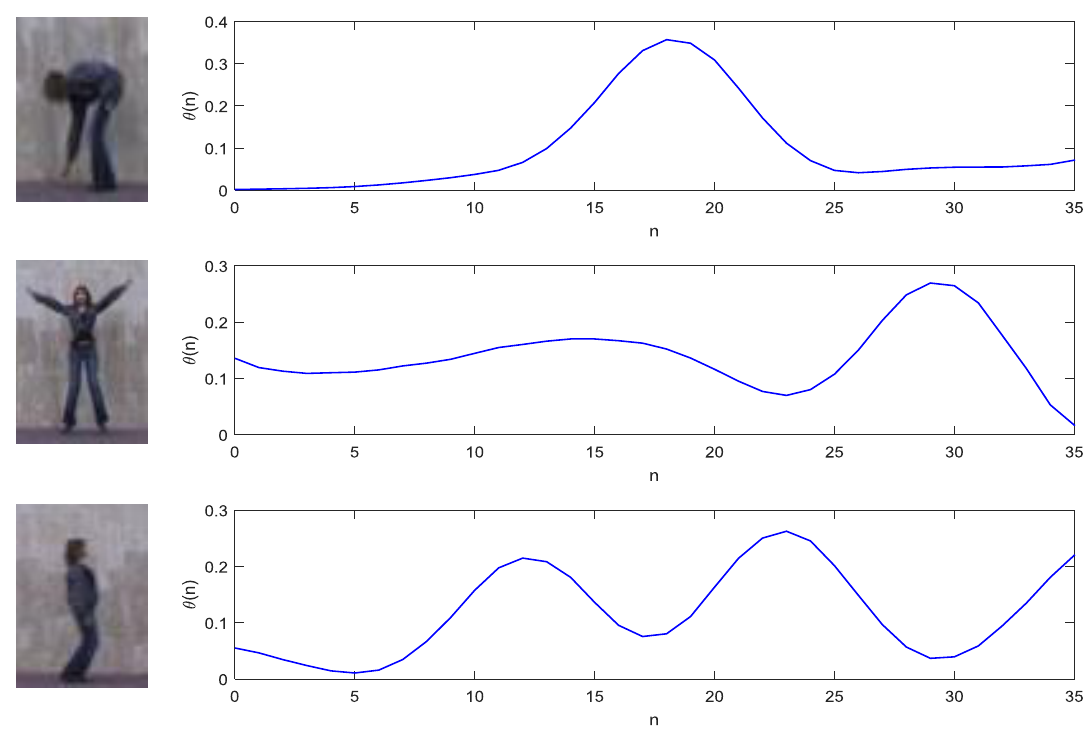
Figure 5. A sample of three actions along with their corresponding smoothed f-HOL features; from top to bottom , the actions are “Bend”, “Jack”, and “Jump”,